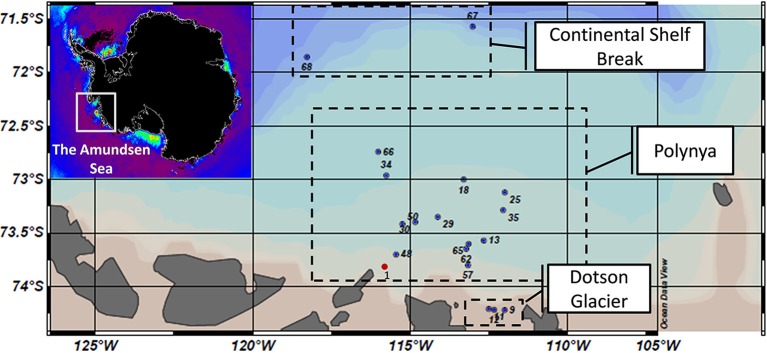
Map of sampling sites across the Amundsen Sea polynya that were visited during the Oden Southern Ocean (OSO) cruise in 2007–2008 (red dot) and the ASPIRE cruise in 2010–2011 (blue dots). Samples were grouped into three major regions: the Continental Shelf Break, the open waters of the polynya and waters abutting the Dotson Glacier. Insert: A map of chlorophyll a concentrations (red: high; purple: low) in polynyas abutting the Antarctic continent as estimated by remote sensing (courtesy of Dr. Kevin R. Arrigo, Stanford University). Note that sample numbers are only informative of the station number tracked during the ASPIRE cruise. The corresponding samples are presented in the supplemental material.